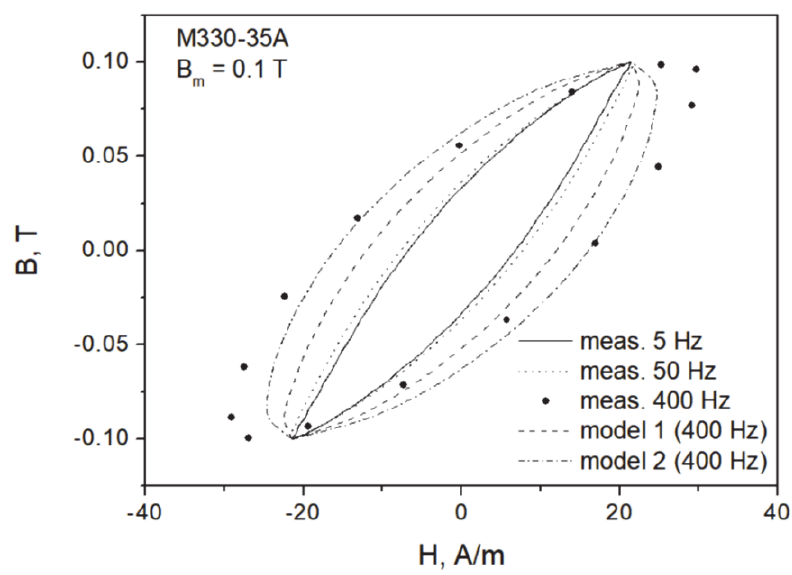
Figure 11. Measured and modeled hysteresis loop for Bm = 0.1 T, f = 400 Hz, M330-35A grade.